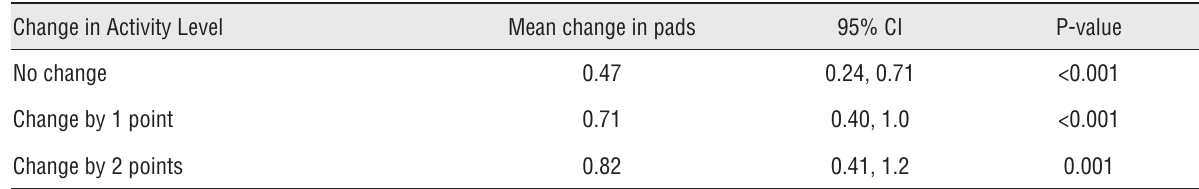
Table 4 - variation in Activity Level & Mean Change in number of